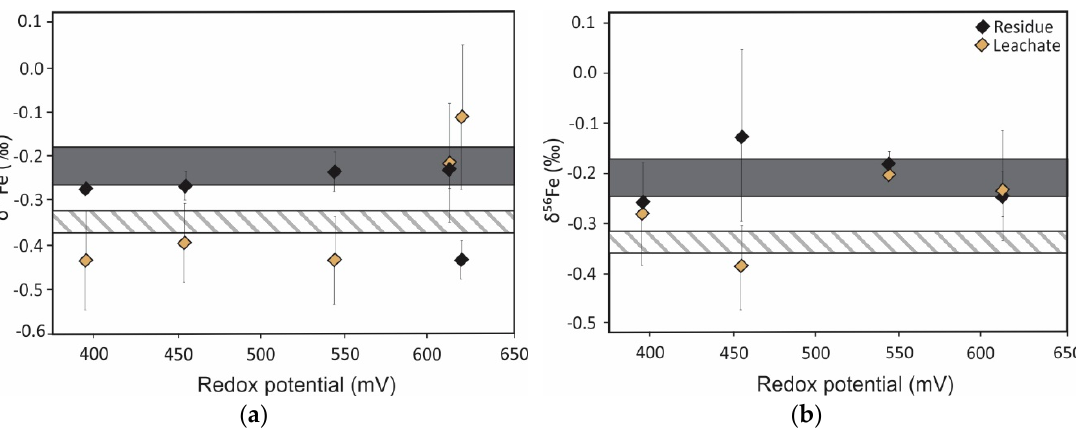
Figure 8. Plot of δ 56 Fe values in residues and leachates as a function of redox potential for ( a ) bioleaching and ( b ) electrochemical leaching of pyritic chalcopyrite concentrate. Grey areas represent the initial isotopic composition of the mineral concentrate with 2 σ errors. Dashed areas represent the initial isotopic composition of the solution with 2 σ errors. Error bars of samples are 2 σ . Redrawn from Pérez Rodríguez et al. [138].